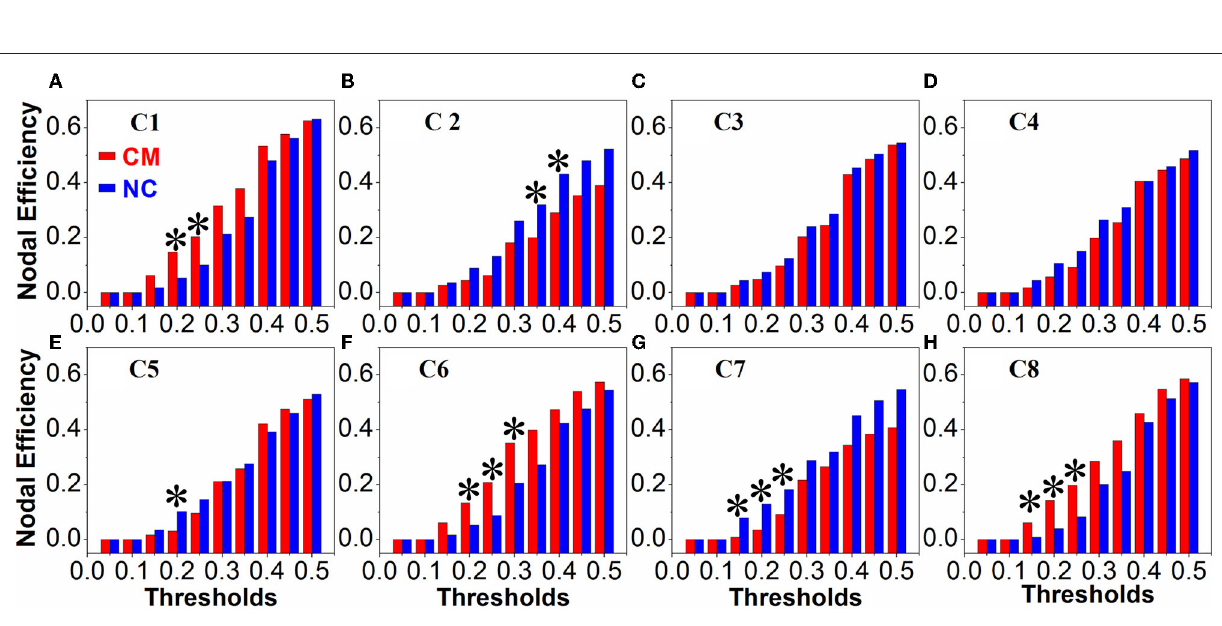
FIGURE 4 | Nodal efficiency values of CM significantly increased on C1 (at thresholds of 0.2 and 0.25), C6 (at thresholds of 0.2, 0.25, and 0.3), and C8 (at thresholds of 0.15, 0.2, and 0.25), and significantly decreased on C2 (at thresholds of 0.35 and 0.4), C5 (at threshold of 0.2) and C7 (at thresholds of 0.15, 0.2, and 0.25). * p < 0.05. (A–H) All the vertical coordinates of subfigures are nodal efficiency, and all the horizontal axis were thresholds. The symbol * at each subfigure indicates that the nodal efficiency of the cluster was significantly changed at the corresponding threshold. touch, pressure, temperature, and pain. Previous studies have somatosensory cortices. It contributes to aspects of receptive uncovered robust correlation between the visual cortex and language, such as phonology, reading, and spelling, particularly post-central gyrus in sighted people, which was involved in in the language-dominant hemisphere. The post-central gyrus the combining process of spatial visual and somatosensory corresponds to the primary somatosensory cortex and it information perceives various somatic sensations from the body, such as